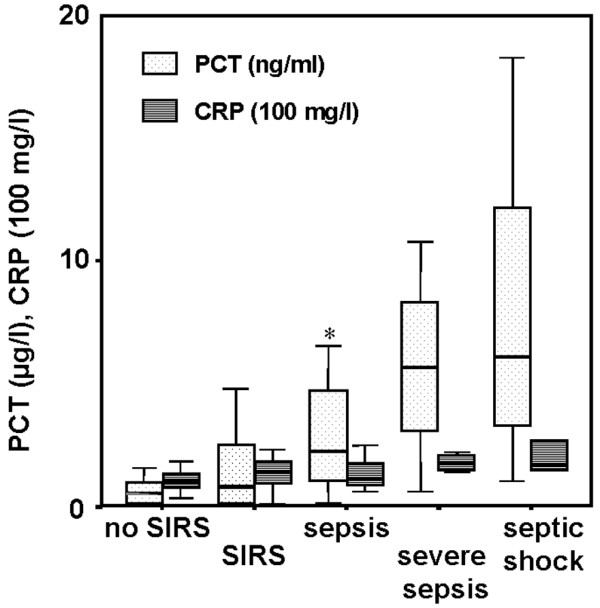
Initial serum concentrations of procalcitonin (PCT) (0–48 hours) and C-reactive protein (CRP) (0–72 hours) after mechanical trauma, and the development of septic complications during a 21-day follow-up. SIRS, systemic inflammatory response syndrome.